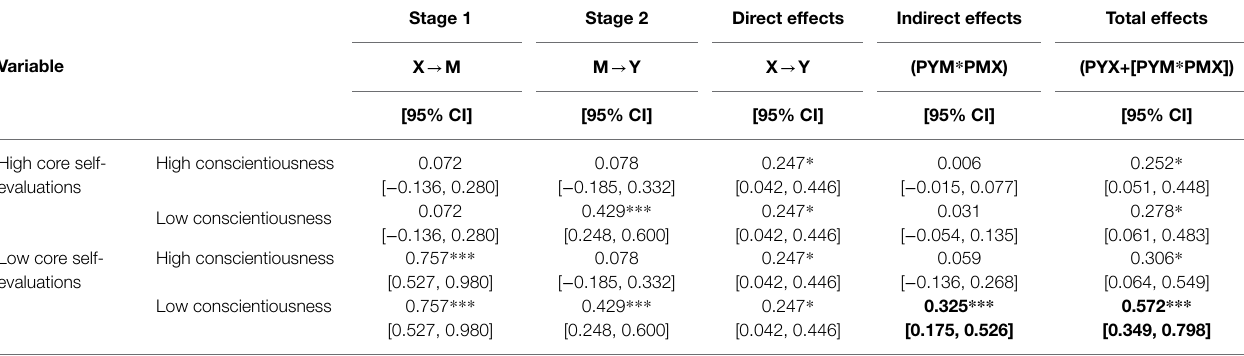
TABLE 6 | Analysis results of moderated mediation effect of two